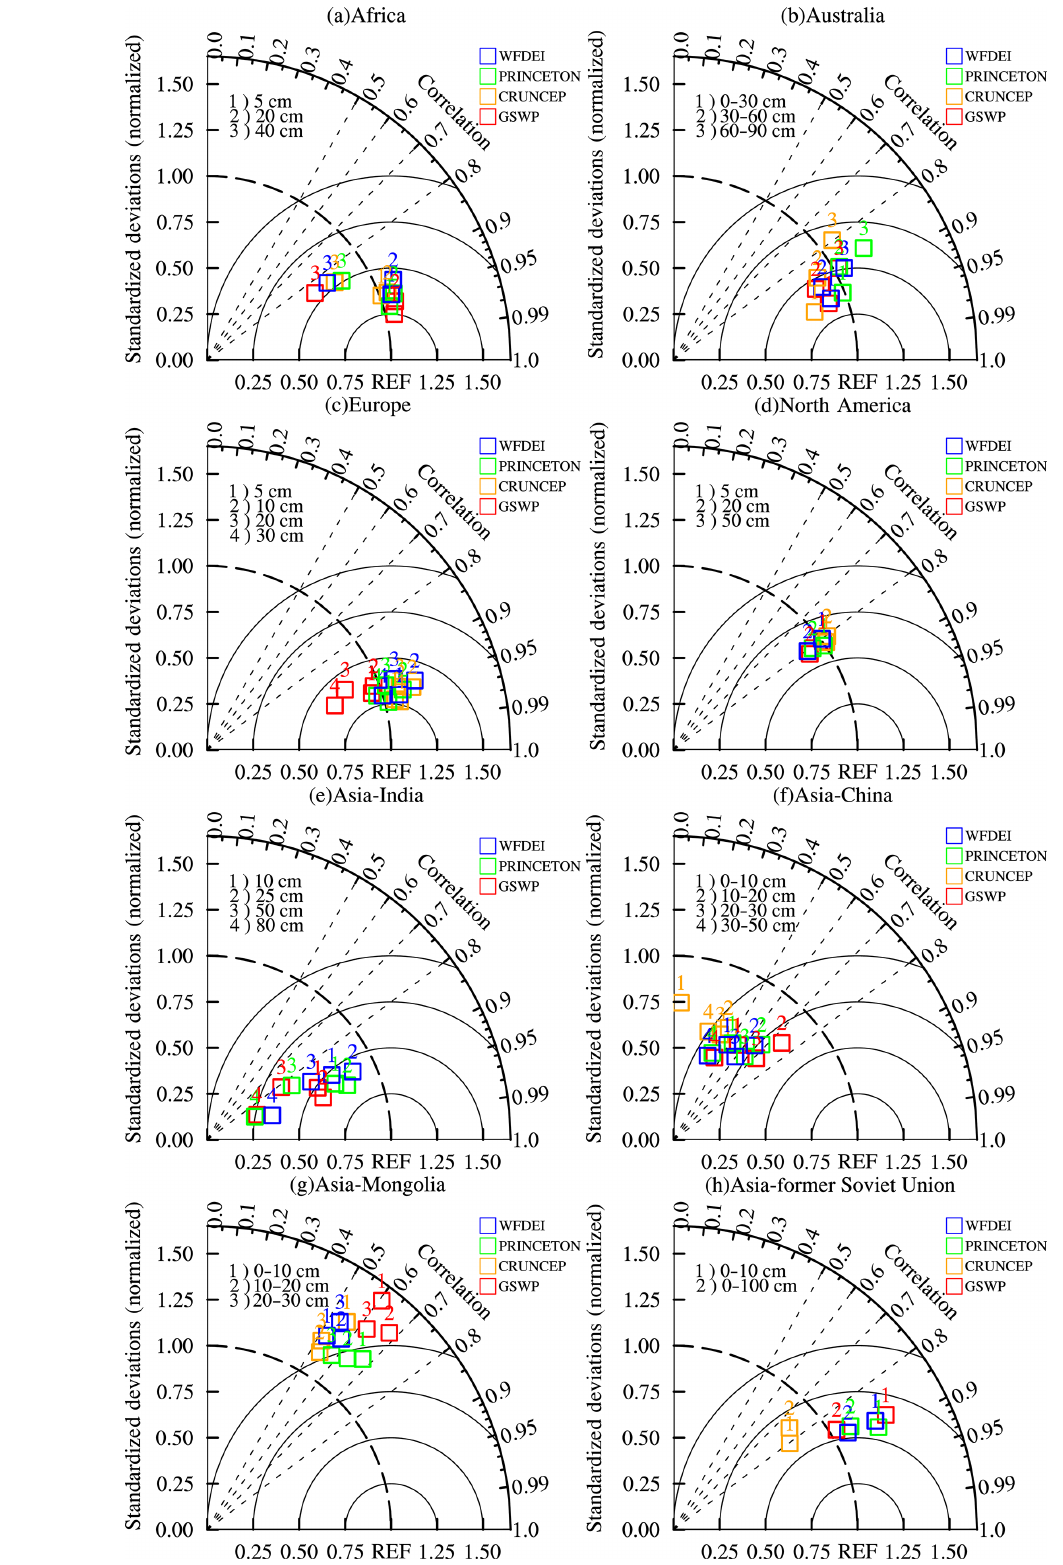
Figure 3. Taylor diagrams illustrating the comparisons among GSWP, CRUNCEP, PRINCETON, WFDEI, and in situ observation data.